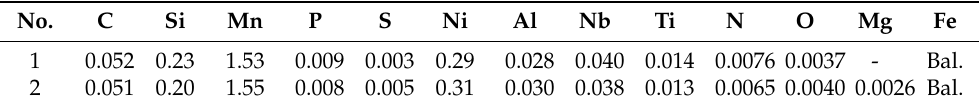
Table 2. Chemical composition of test steel, wt.%.